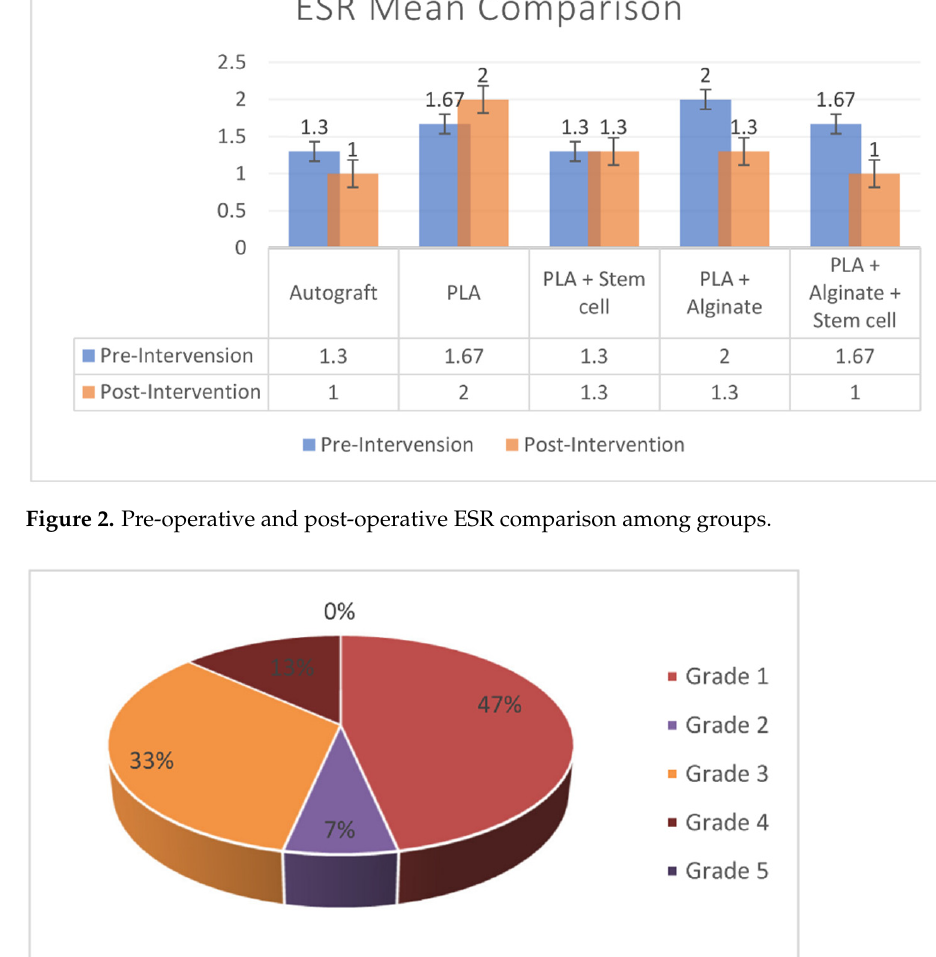
Figure 2 . Pre-operative and post-operative ESR comparison among groups.